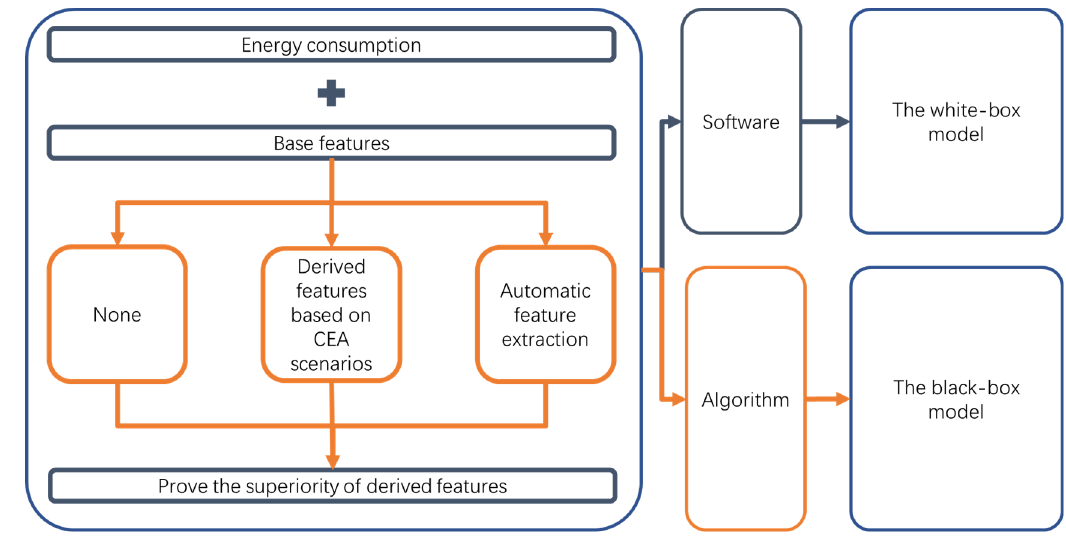
Figure 3. Flowchart of this study.